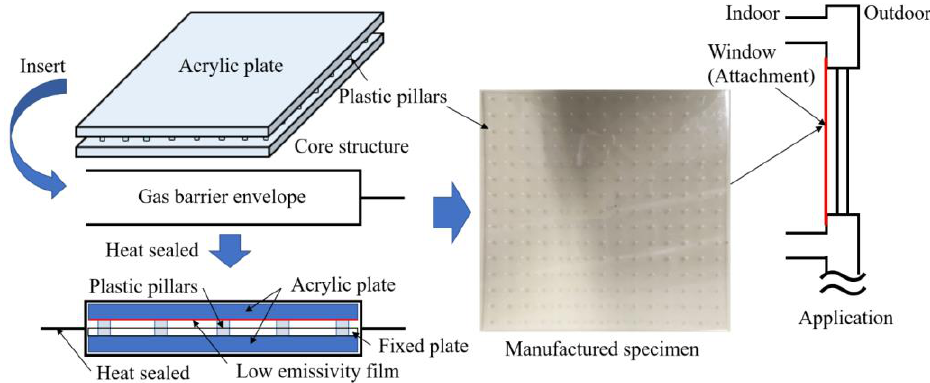
Figure 1. Concept diagram of the VIP application to buildings.